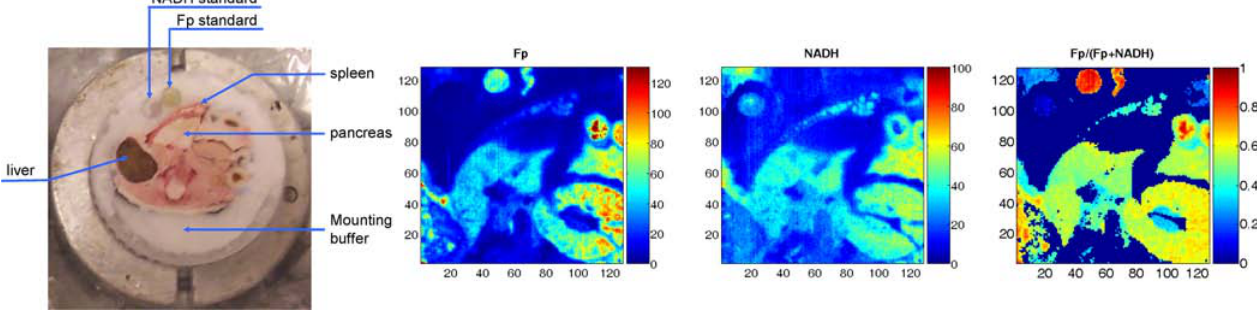
Fig. 7. First redox image of di®erent mouse